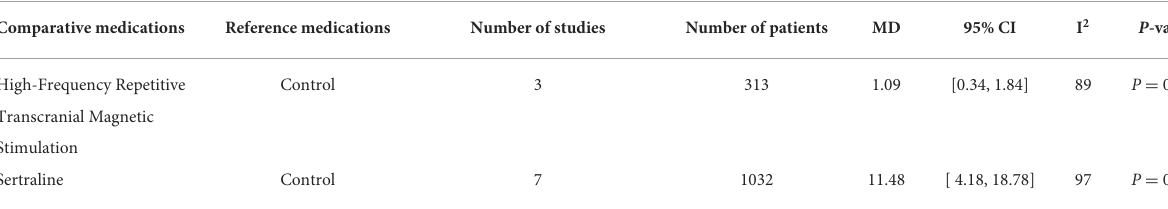
TABLE 4 Results of pairwise meta-analyses for neurologic function.